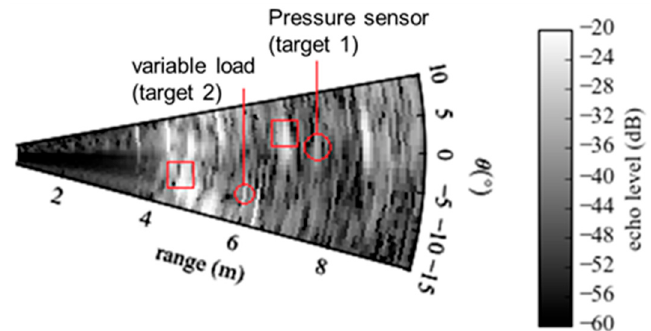
Figure 6. Radar image of the scene in the cut-plane φ = 2°. The scene includes two passive targets. (1) Target n°1: the zero-power pressure sensor with its horn antenna (the applied pressure is of 2.4 bars). (2) Target n°2: the horn antenna loaded by a variable microwave resistor (the resistance is of 530 Ω ). The antennas are indicated by red squares while the loading devices (i.e., pressure sensor and variable resistor) are indicated by red circles.